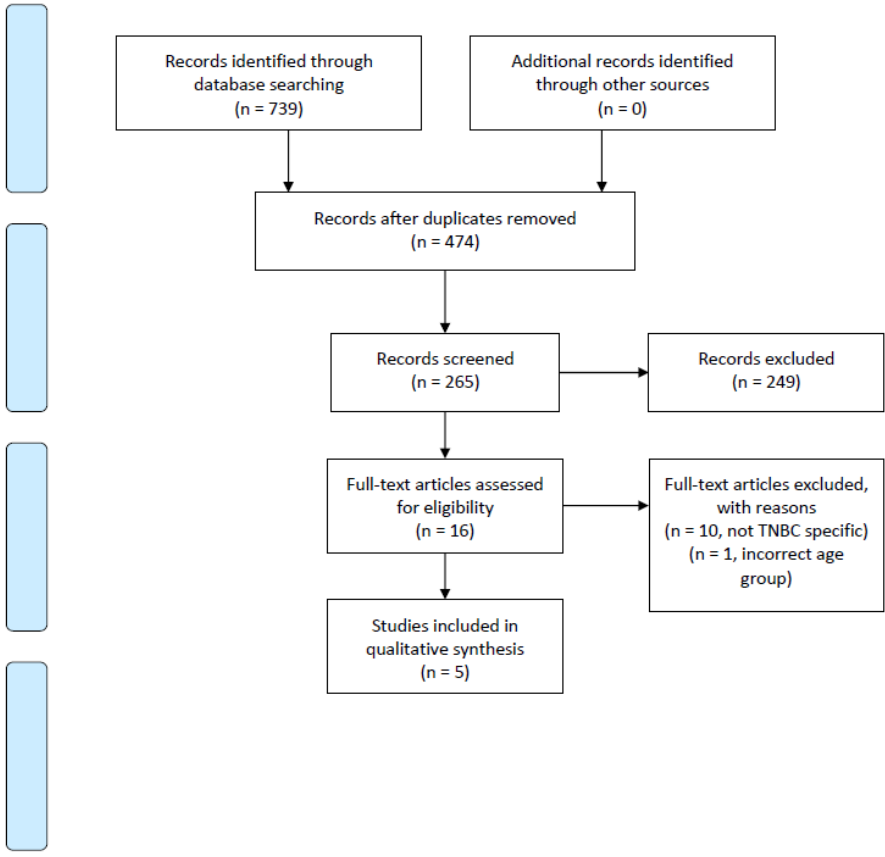
Figure 1. PRISMA 2009 Flow